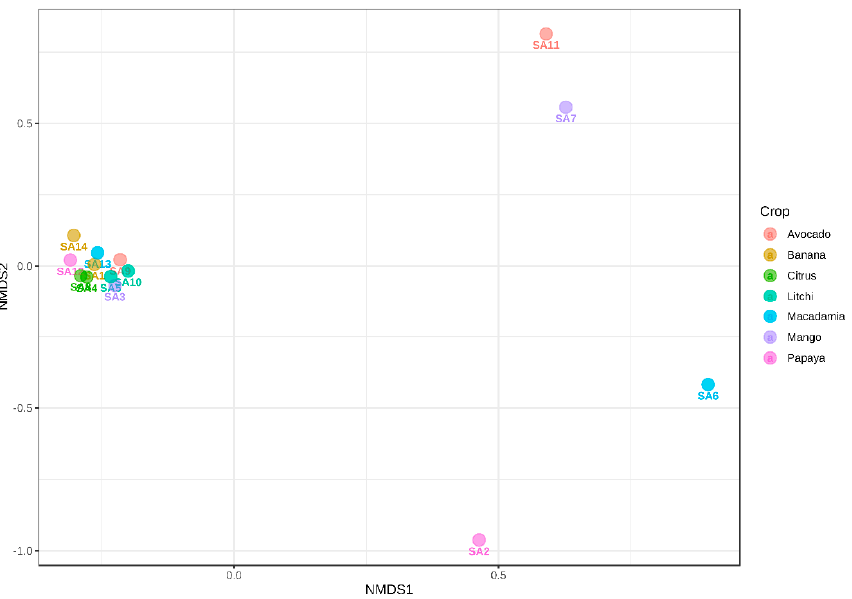
Figure 7. The NMDS diagram indicates the beta-diversity of fungal communities among 14 tropical fruit orchards from Mpumalanga province, South Africa. Permutational MANOVA (PREMANOVA) was used as the statistical method ( p ≤ 0.01), and the Bray–Curtis dissimilarity distance was used to determine differences and similarities among the samples.